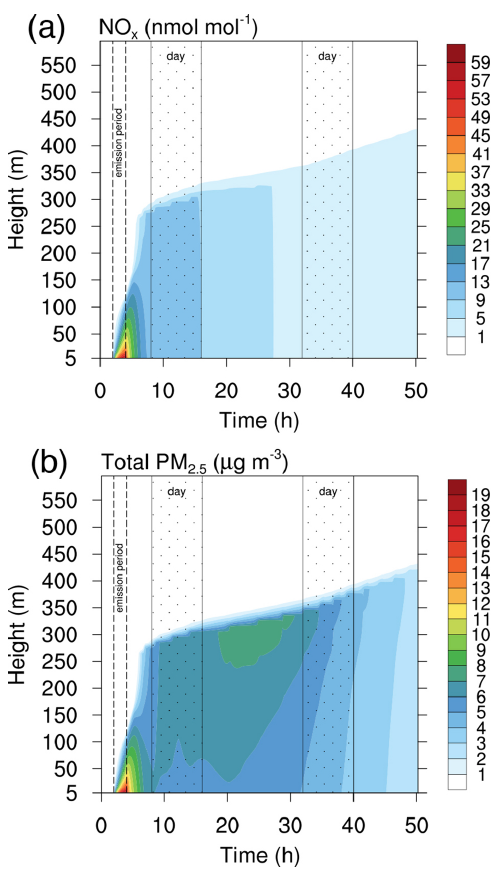
Figure 3. Modeled evolution of primary emission NO x and total PM 2 . 5 beginning at local midnight. Daytime regions are indicated by the dotted region and the emission period is indicated by the dashed lines. Emitted species dilute throughout the mixed layer. NO x undergoes chemical loss (a) while total PM 2 . 5 increases (b) , primarily due to formation of particulate nitrate.